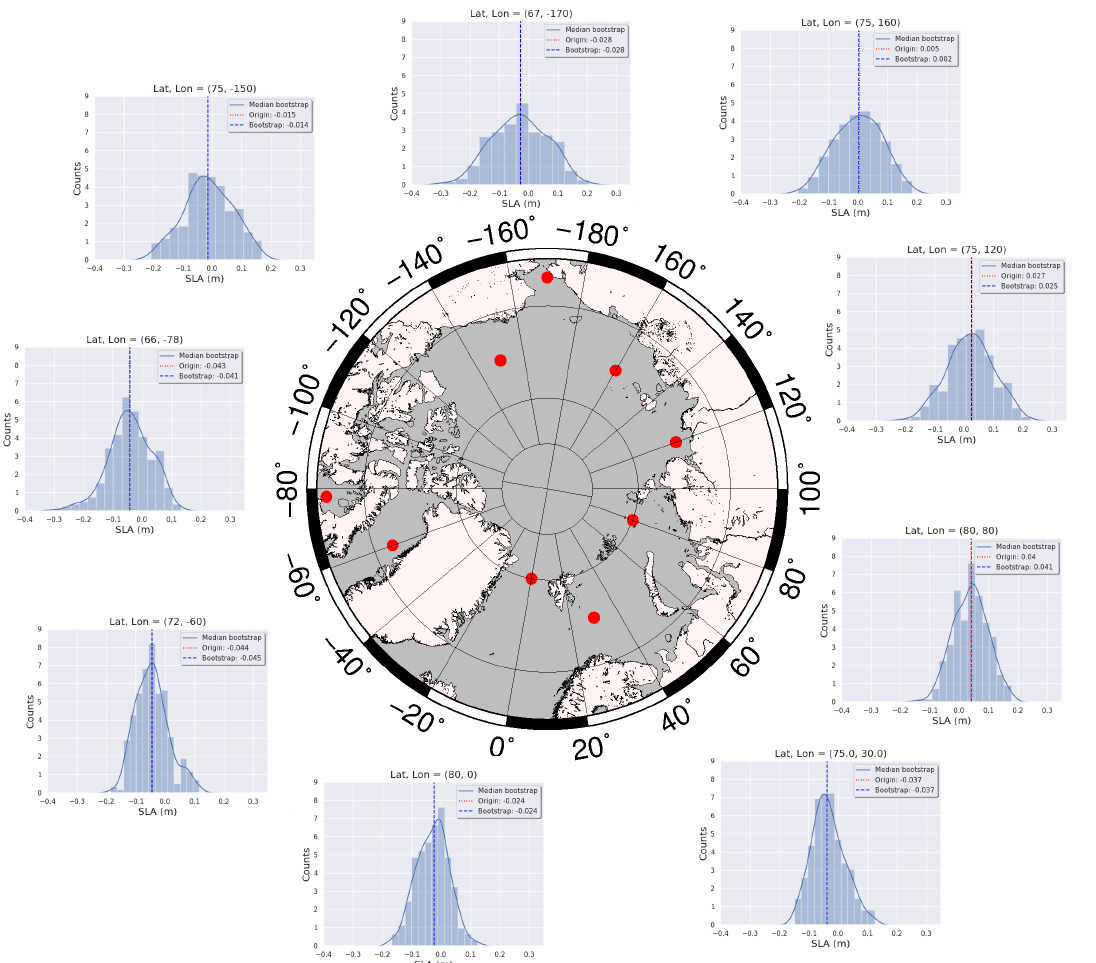
Figure A1. Examples of median bootstrap SLA distribution from January 1991 to September 2018 for various grid points. The vertical lines represent the median of the original SLA (red) and the median bootstrap realizations